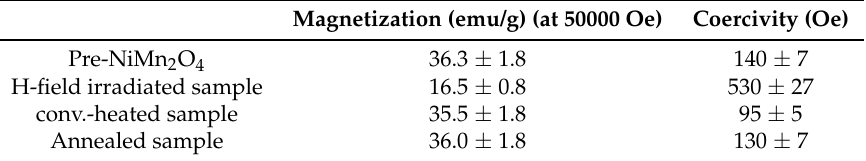
Table 1. Magnetic properties of synthesized NiMn 2 O 4 .